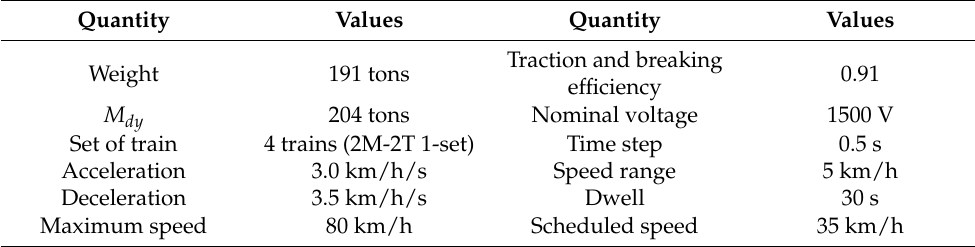
Table 1. Input vehicle data for mTPS.